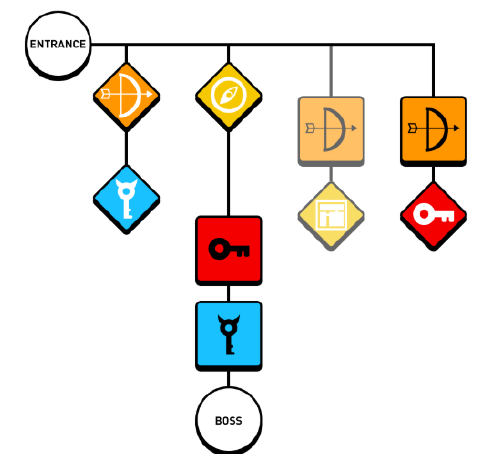
Figure 7. Example of a sketch generated by Smith et al.